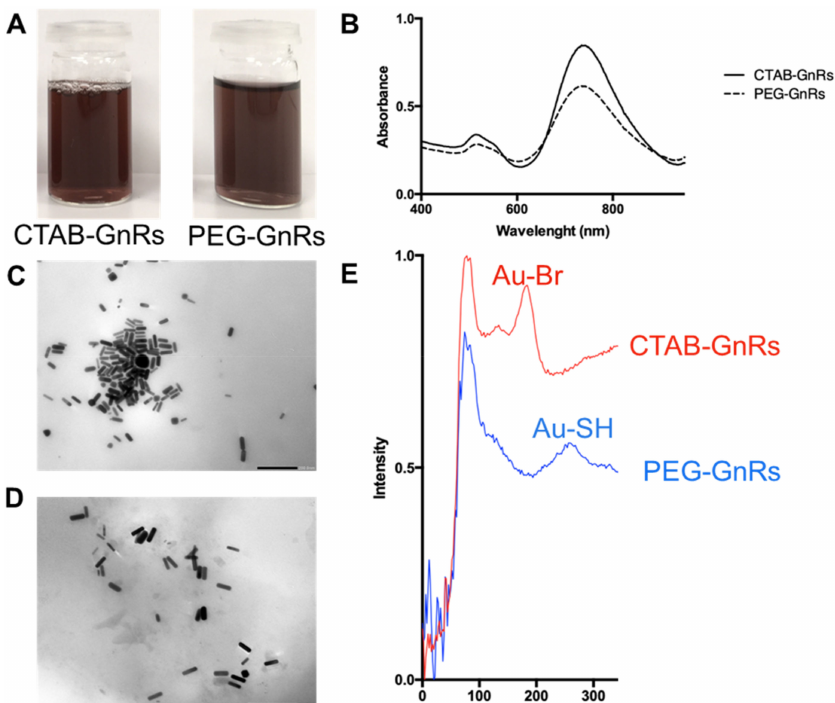
Figure 3. Representative images of GnR samples ( A ). Absorbance spectrum of GnRs within the near-infrared (NIR) spectrum ( B ). Representative transmission electron microscopy (TEM) images of cetyltrimethylammonium bromide GnRs (CTAB-GnRs) ( C ) and pegylated GnRs (PEG-GnRs) ( D ) (scale bar represents 200 nm). Raman spectroscopy of GnRs ( E ).